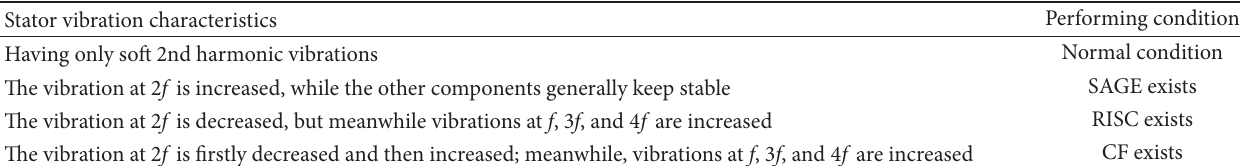
Table 3: Fault identification criterion based on stator vibration characteristics.